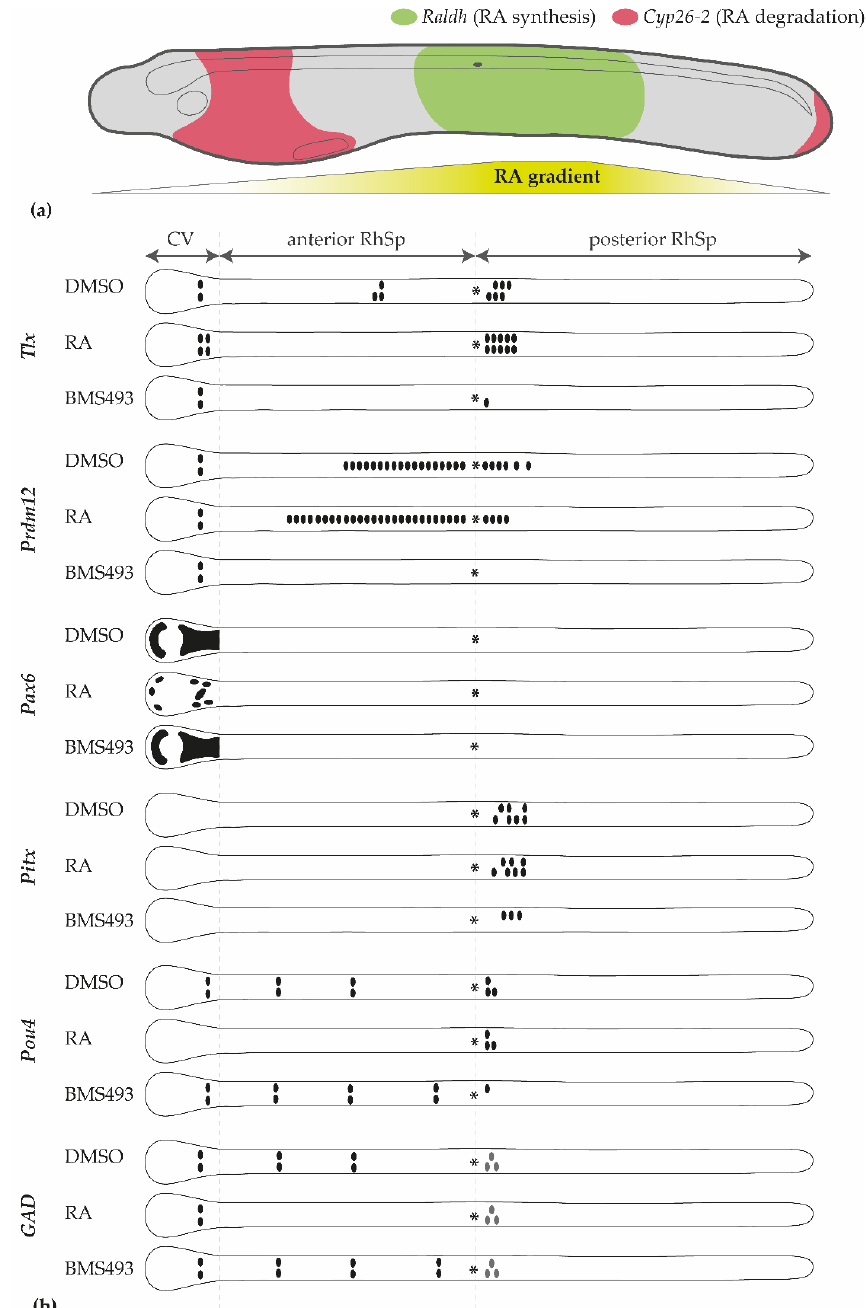
Figure 9. Model of retinoic acid (RA)-dependent regionalization of the amphioxus nerve cord. ( a ) Schematic illustration of the RA gradient in T1-stage embryos as deduced from Raldh and Cyp26-2 expression. The embryo is shown in lateral view, with the anterior on the left. ( b ) Schematic representation of the expression patterns of Tlx , Prdm12 , Pax6 , Pitx , Pou4 , and GAD in the central nervous system of T1-stage embryos in controls (DMSO) and following treatments to upregulate (RA) or inhibit (BMS493) RA signaling activity. Each outline represents the nerve cord of an embryo in dorsal view, with black shapes and dots indicating gene expression and asterisks marking the position of the first pigment spot. The GAD expression domain posterior to the first pigment spot is shown in gray to indicate that the number of cells varies at the T1 stage. CV: cerebral vesicle; RhSp: rhombospinal region. References for expression data: Raldh [78]; Cyp26-2 [79]; Tlx , Prdm12 , Pax6 , and Pitx [45]; GAD